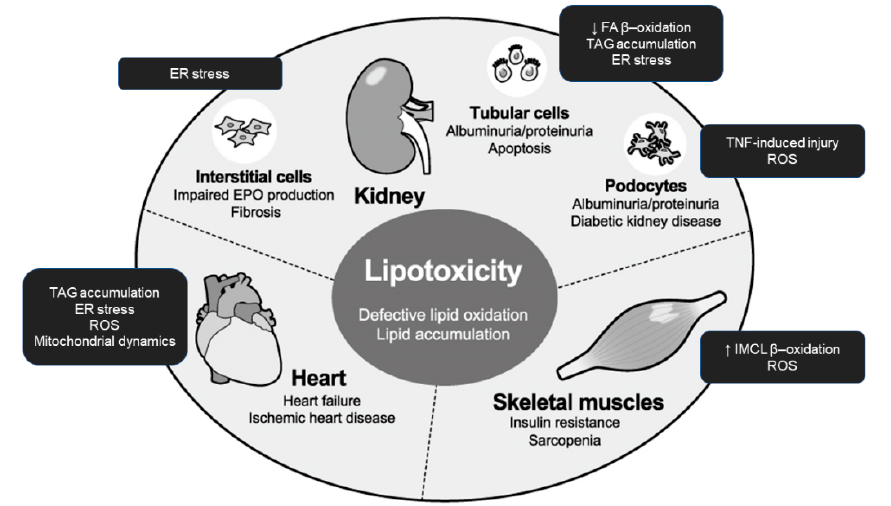
Figure 2. Integrated organ pathology caused by lipotoxicity in uremia. In the presence of prolonged nutrient excess or disturbed metabolism, lipids accumulate ectopically in tissues and organs including the kidney, heart, and skeletal muscle. The endpoints of lipotoxicity vary among those targets and include urinary albumin excretion and impaired erythropoietin production in the kidney, heart failure, and insulin resistance and mass reduction (sarcopenia) in the skeletal muscle. EPO: erythropoietin; ER: endoplasmic reticulum; ROS: reactive oxygen species; FA: fatty acid; TNF: tumor necrosis factor; IMCL: intramyocellular lipid; TAG: triacylglycerol.